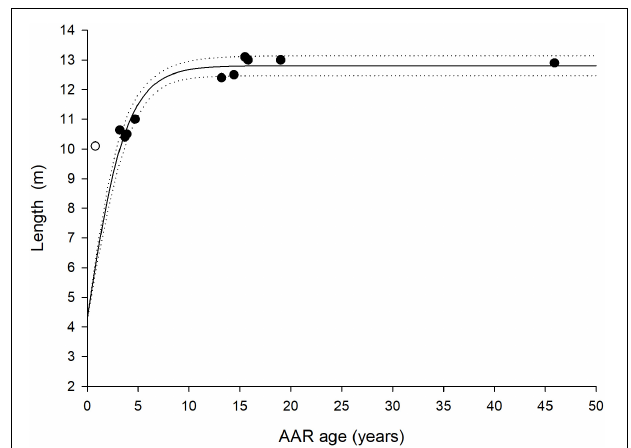
FIGURE 2 | Age and length relation of the 11 humpback whales of know size (black circles). The solid line is a Gompertz growth curve fitted to the data and dashed lines indicate 95% confidence intervals. The white circle represents whale ID Mn002 where there is uncertainty in regards to the registered length. A birth length (i.e., intercept) of 4.3 m is assumed (Chittleborough,